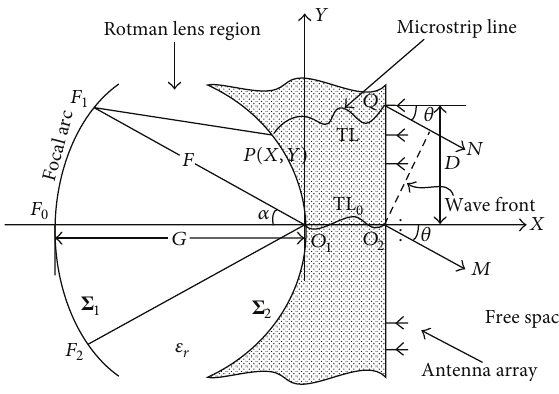
Figure 1: Printed Rotman lens parameters.